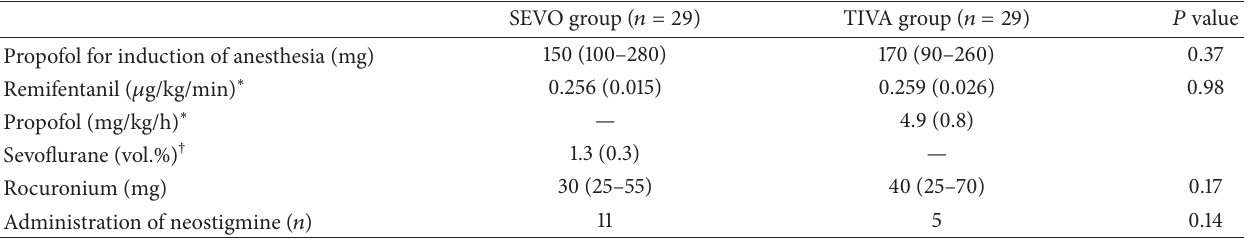
Table 2: Doses of rocuronium, propofol, remifentanil, and end-tidal concentrations of sevoflurane and administration of neostigmine. SEVO group ( 𝑛 = 29 ) TIVA group ( 𝑛 = 29 )